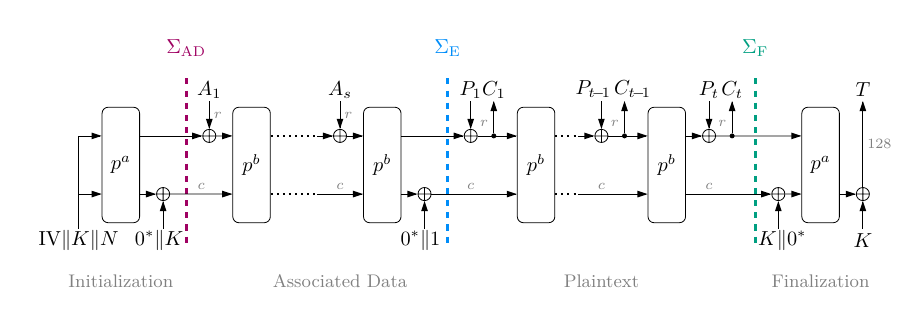
Figure 1: Ascon AEAD encryption. 1